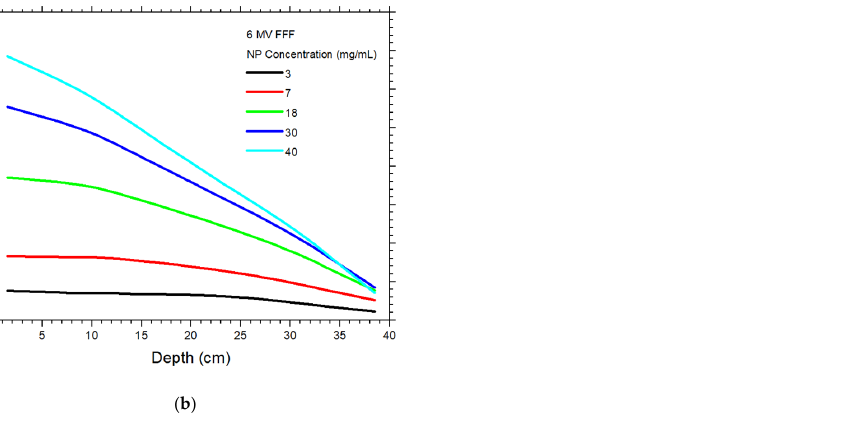
Figure 3. Relationships of dose enhancement ratio and phantom depth with variation of NP concentration using the ( a ) 6 MV FF and ( b ) 6 MV FFF photon beams.